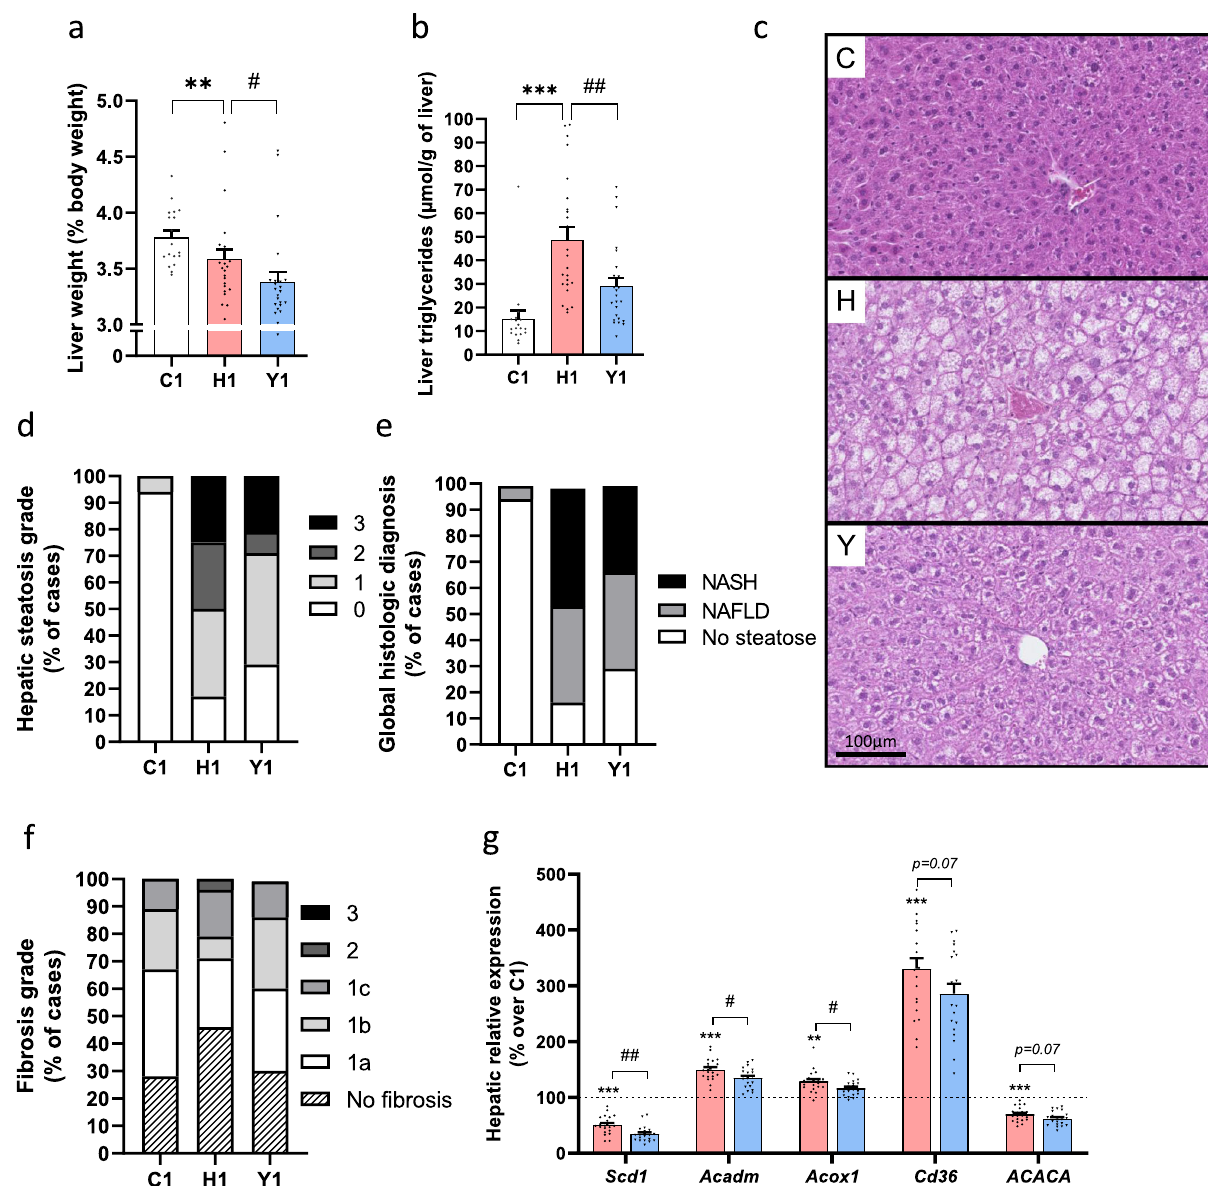
Fig. 2 Yogurt preserves hepatic steatosis and function. Liver state in mice from Study 1. a Liver weight. b Hepatic triglyceride content. c Representative liver sections (hematoxylin and eosin staining) of n = 16 – 24 sections from independent mice. d , e Pathological analyses of liver sections. d Hepatic steatosis. e Global histologic diagnosis. f Fibrosis score. g Liver expression of genes involved in fatty acid uptake, de novo lipogenesis and fatty acid oxidation. Data are expressed as mean ± SEM. n = 18 – 24 biologically independent mice, except for panel ( g ) ( n = 8 for C1 group, n = 20 for H1 and Y1 groups). H versus C: ** p < 0.01, *** p < 0.001. Y versus H: # p < 0.05, ## p < 0.01. For panel ( g ) expressed in percentage, C group is considered as a reference and represented by a dash line. C: low-fat low-sucrose control diet (C1: white); H: high-fat high-sucrose diet with a protein mixture replacing casein (H1: pink); Y: lyophilized yogurt incorporated in H diet (Y1: light blue). Number (1) refers to the study af fi liation. Mann – Whitney tests or T -test depending on data distributions ( a , b ). One-way ANOVAs and Benjamini – Hochberg adjustment for multiple testing on the number of variables ( g ). All tests were two-